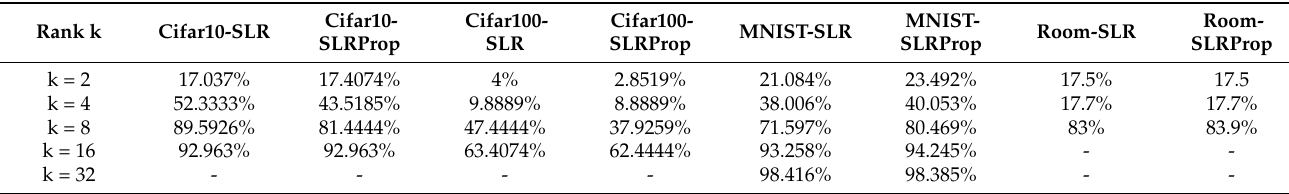
Table 4. SLR vs. SLRProp accuracies for different